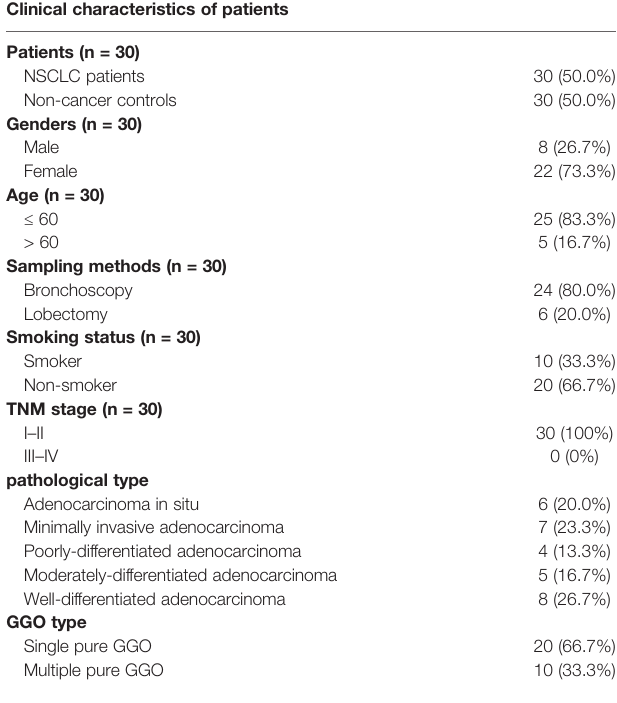
TABLE 1 | Clinical characteristics of